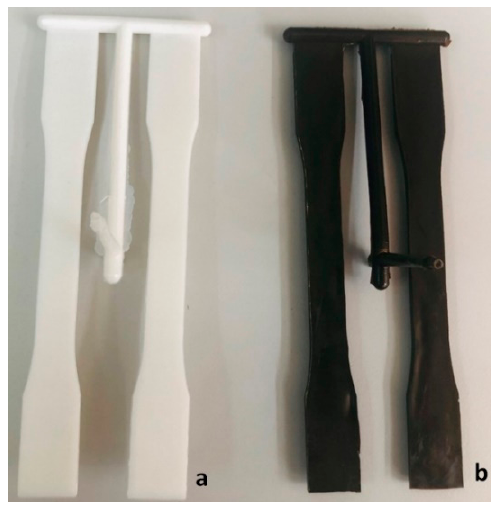
Figure 1. Image of dog bone test specimen prepared: ( a ) blend and ( b ) composites reinforced with 15 wt.% lignin.